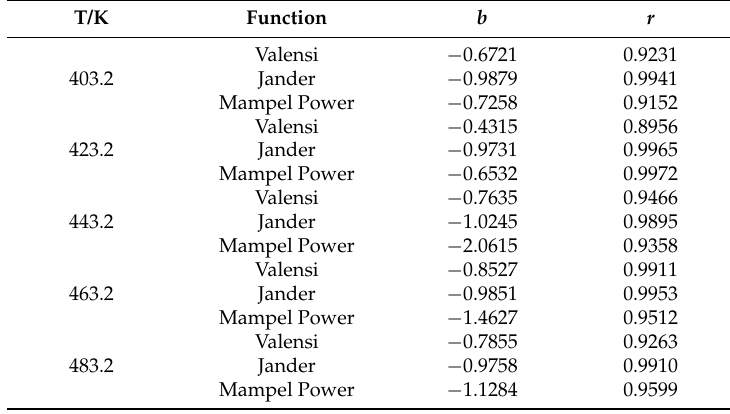
Table 5. Part of the results from the linear least squares method at different kinetic mechanisms